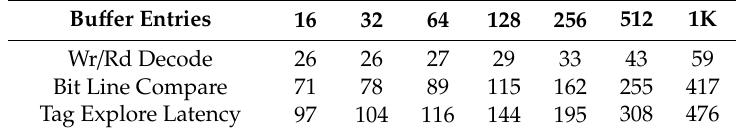
Table 2. Access latency values (ps) of history bu ff er with di ff erent entries